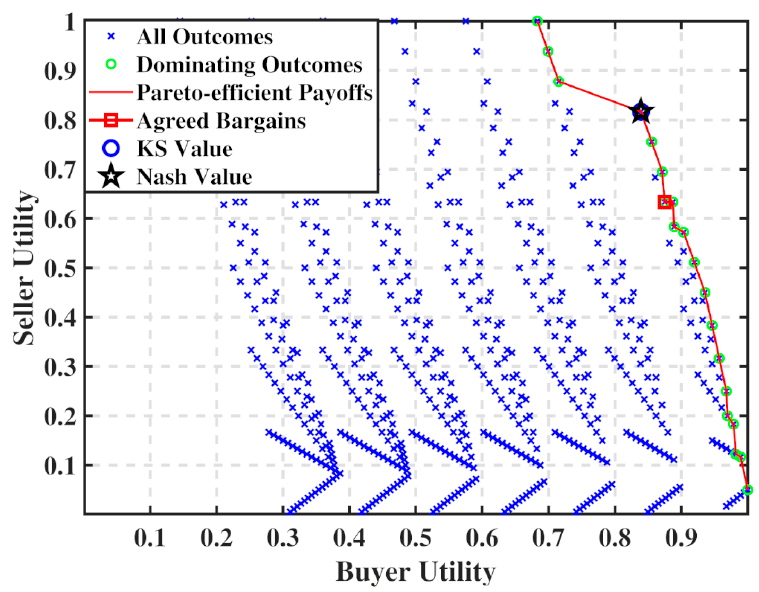
Figure 4. Automated negotiation possible outcomes space for seller and buyer 2 expert agents.